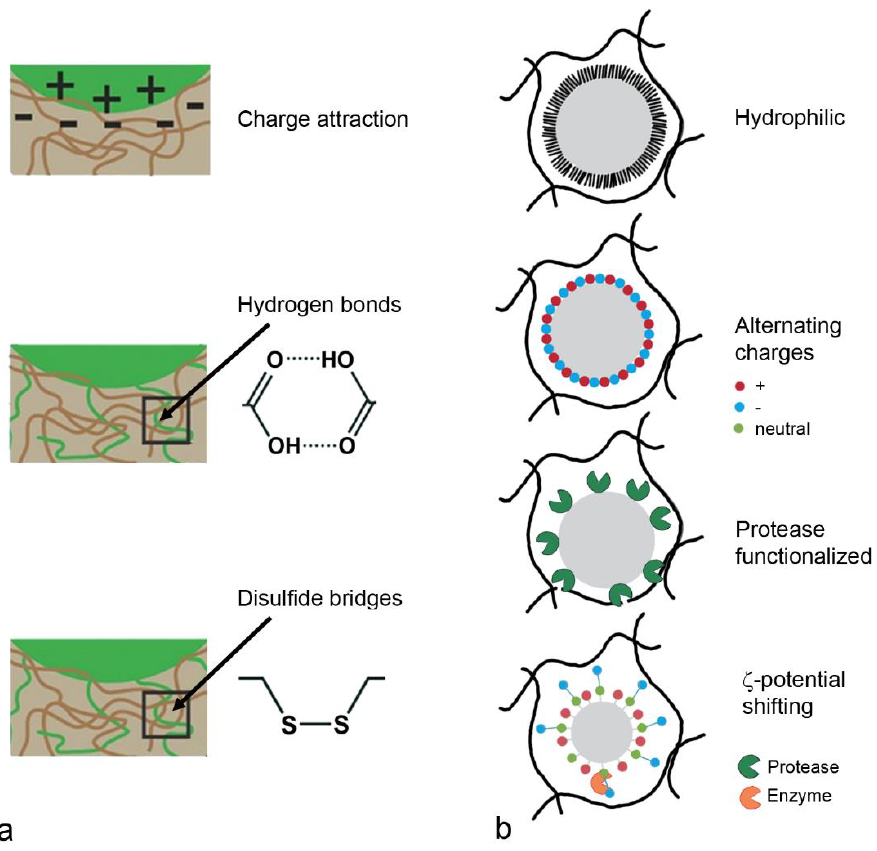
Figure 5. Coating for drug delivery systems based on mucoadhesion ( a ) use electrostatic interaction, hydrogen bonds and disulfide bridges. Mucopenetration ( b ) can be achieved by hydrophilic particles, particles with alternating charges, protease-functionalized particles and ξ–potential shifting particles. Colored dots indicate positive (red), negative (blue) and neutral (green) charge.